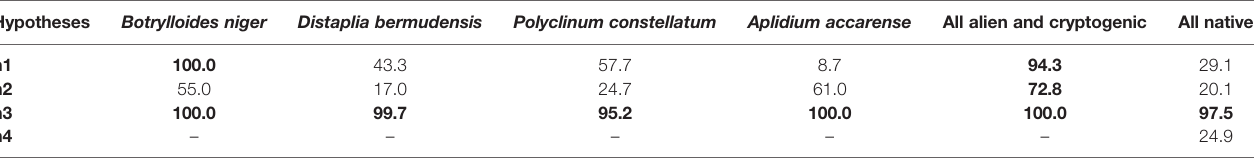
Hypotheses with high support (>70%) highlighted in